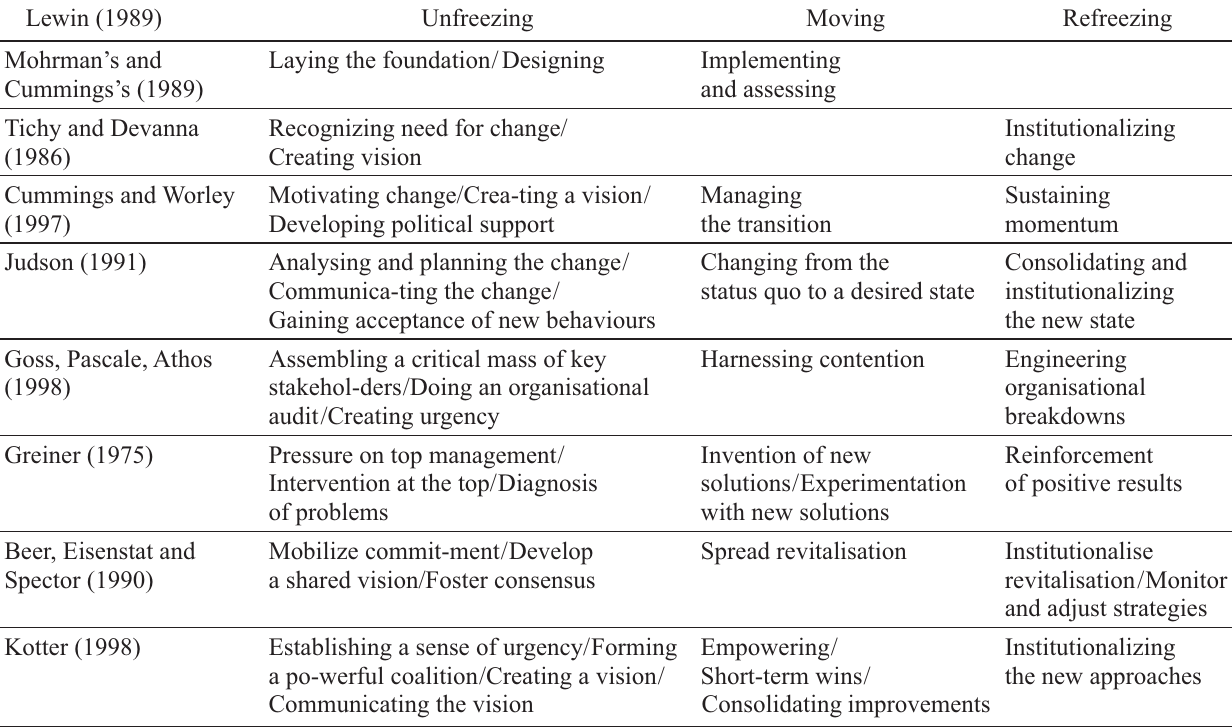
Table 1. A comparison of steps in process theories of